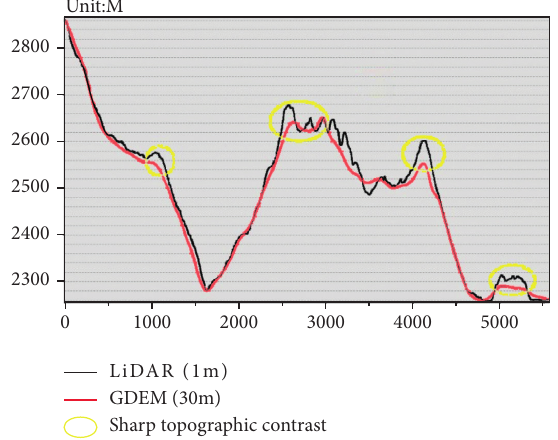
Figure 4: Comparison of the 1 m resolution DEM from LiDAR and the 30m AsterGDEM DEM terrain profile data.